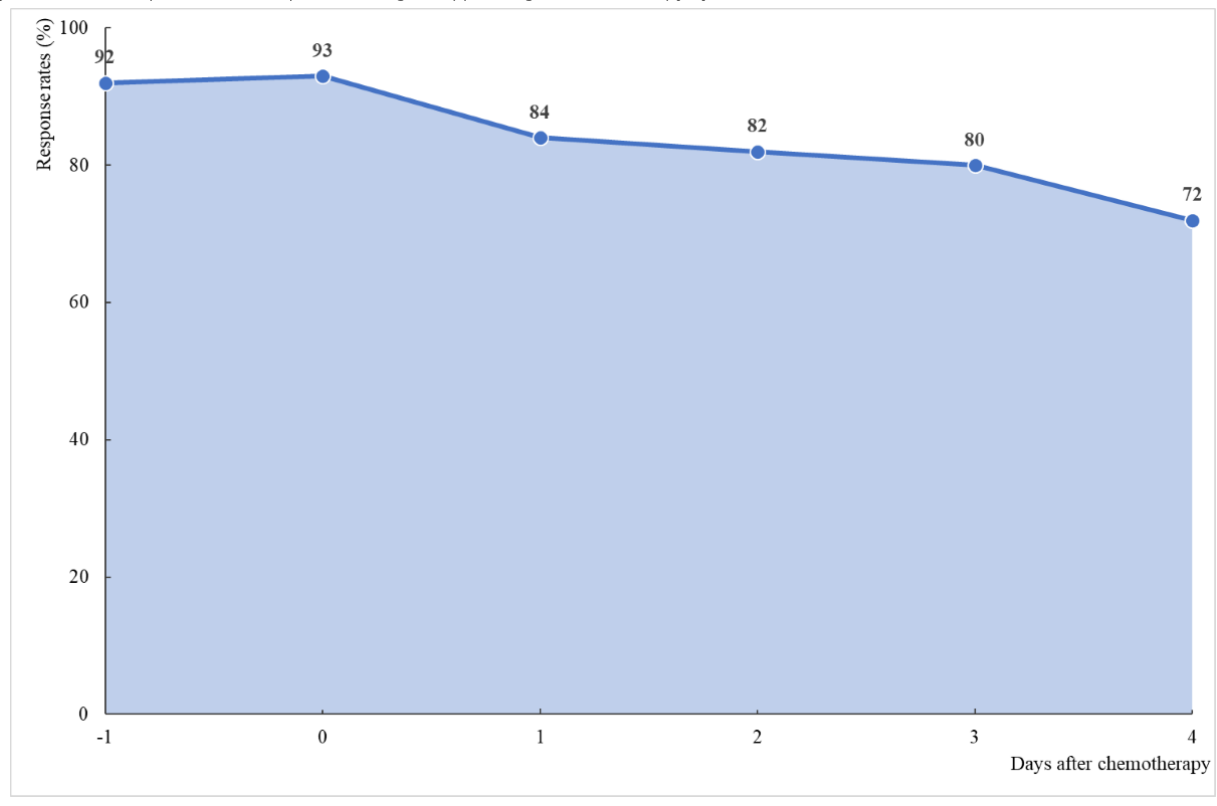
Figure 4. Data completeness for 20 patients using the app during 60 chemotherapy